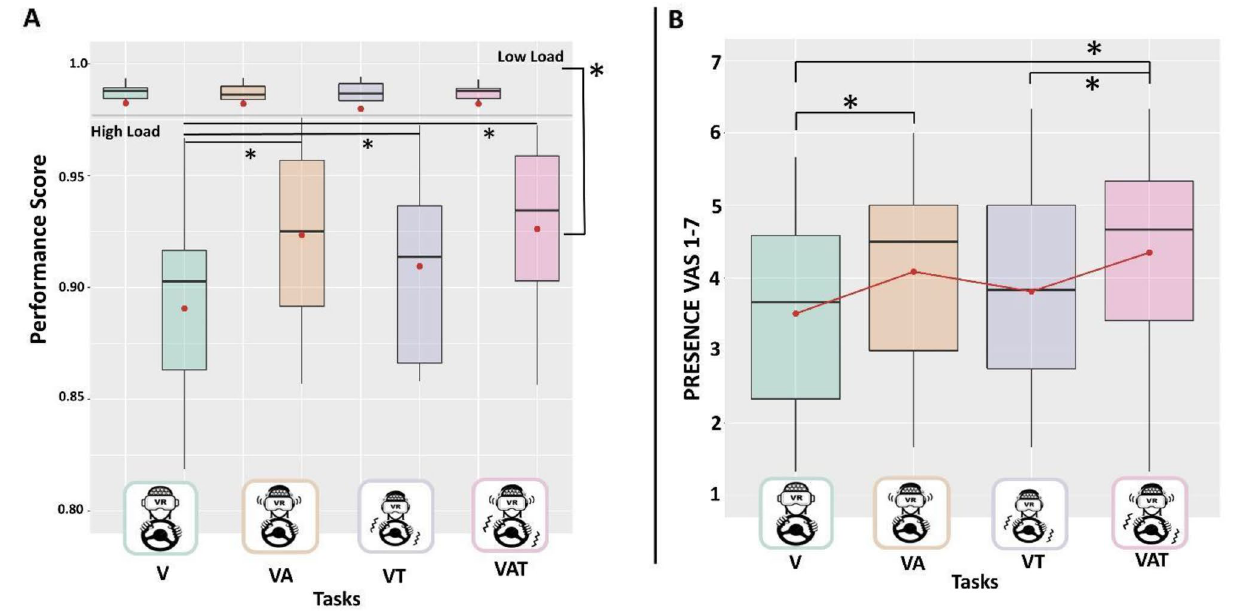
Figure 2. Boxplots representing behavioural correlates of the ( A ) Performance Index for the low load condition (top) and high load condition (bottom) for each sensory task; ( B ) presence questionnaire scores across the sensory tasks. The questionnaire proposed at the end of each run consisted of three items on a scale from 1 to 7. These scores were averaged to obtain a single value for each condition. The black asterisks indicate significant post-hoc tests while red dots and lines refer to the mean. The central line represents the median, the top and the bottom of the box are the first and third quartiles, and the whiskers are the interquartile range of the lower quartile and of the upper quartile multiplied by